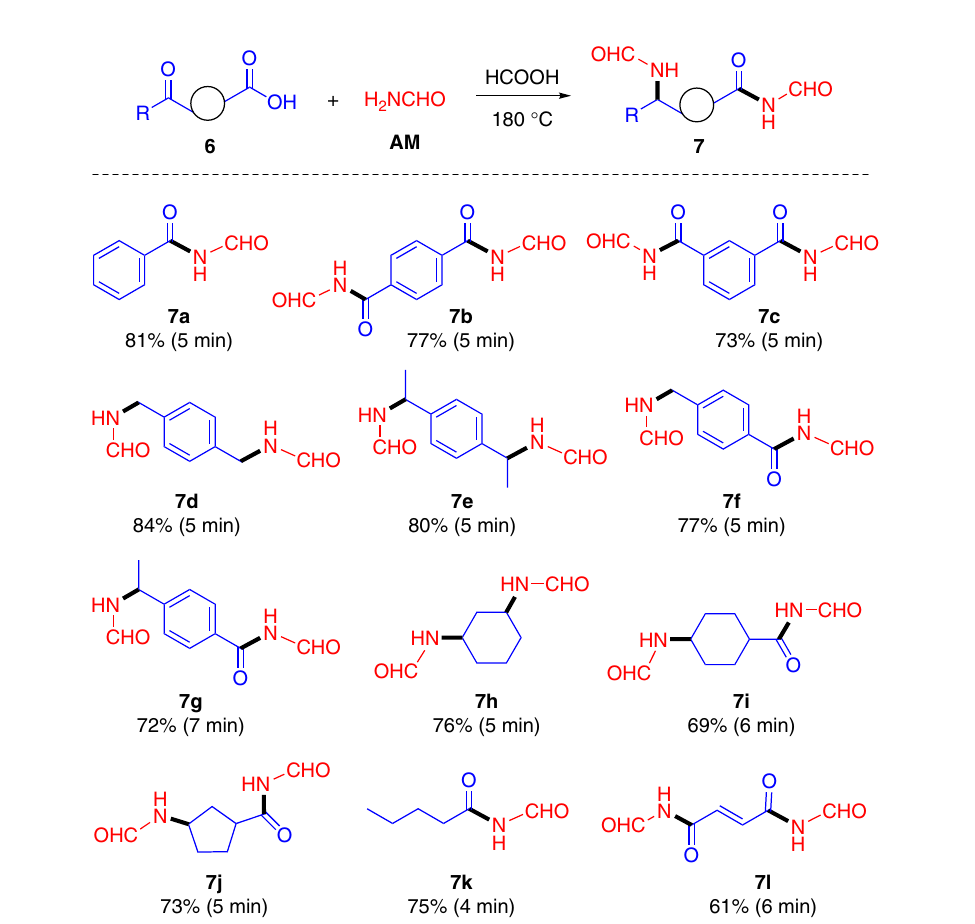
Fig. 5 Synthesis of N-formylimides and N-formamide moieties ( 7 ) from AM and carbonyl compound ( 6 ). Reaction conditions: 1 mmol 6 , 12 mmol AM, 12 mmol FA, 180 °C FUR and 5-hydroxymethylfurfural (HMF) are two important sources, affording homologous N -methyl-furfuryl and N , N - platform molecules derived from pentose and hexose saccharides, dimethyl-furfuryl amines (Table 3, entries 4 – 6). However, presence respectively 59,60 , both of which could be subjected to amination of the hydroxy group in HMF, while being inert for amination, (Table 3, entries 1 and 2). Besides formamide, N -methylformamide causes serious side reactions like condensation or polymerization and N , N -dimethylformamide were able to be used as nitrogen to give insoluble black humins, especially after long reaction times.